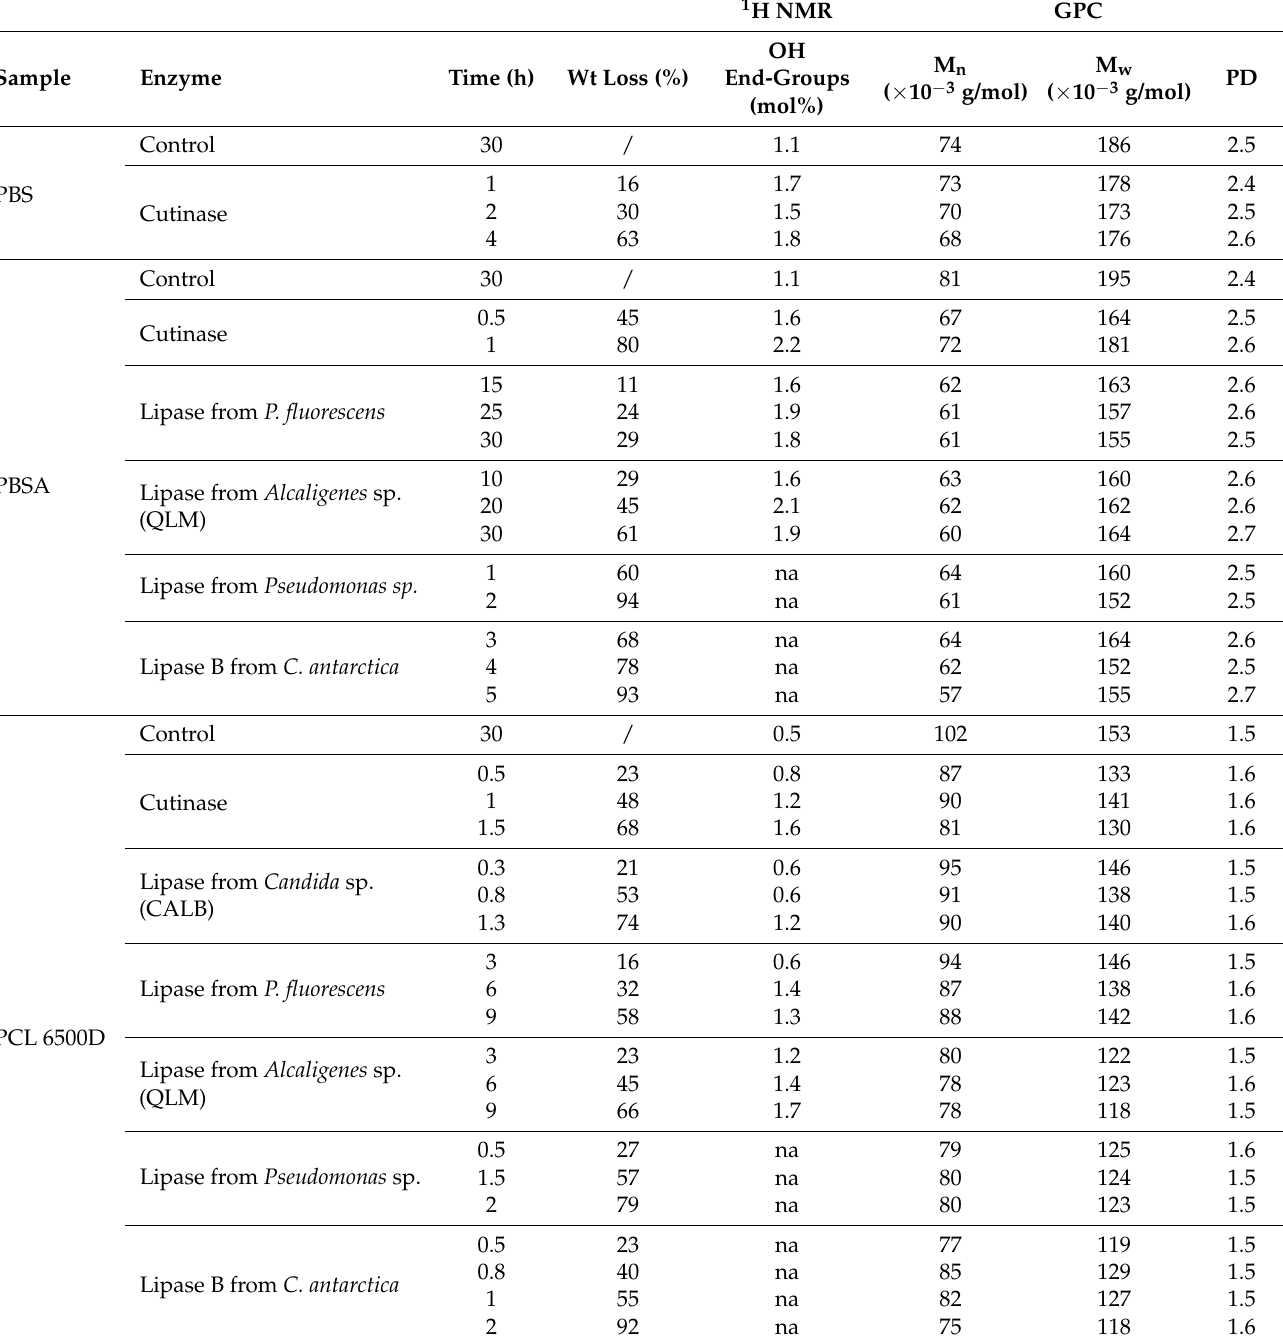
Table 5. 1 H NMR and GPC of PBS, PBSA, PCL6500D and PCL6800D residual solids after treatment with different